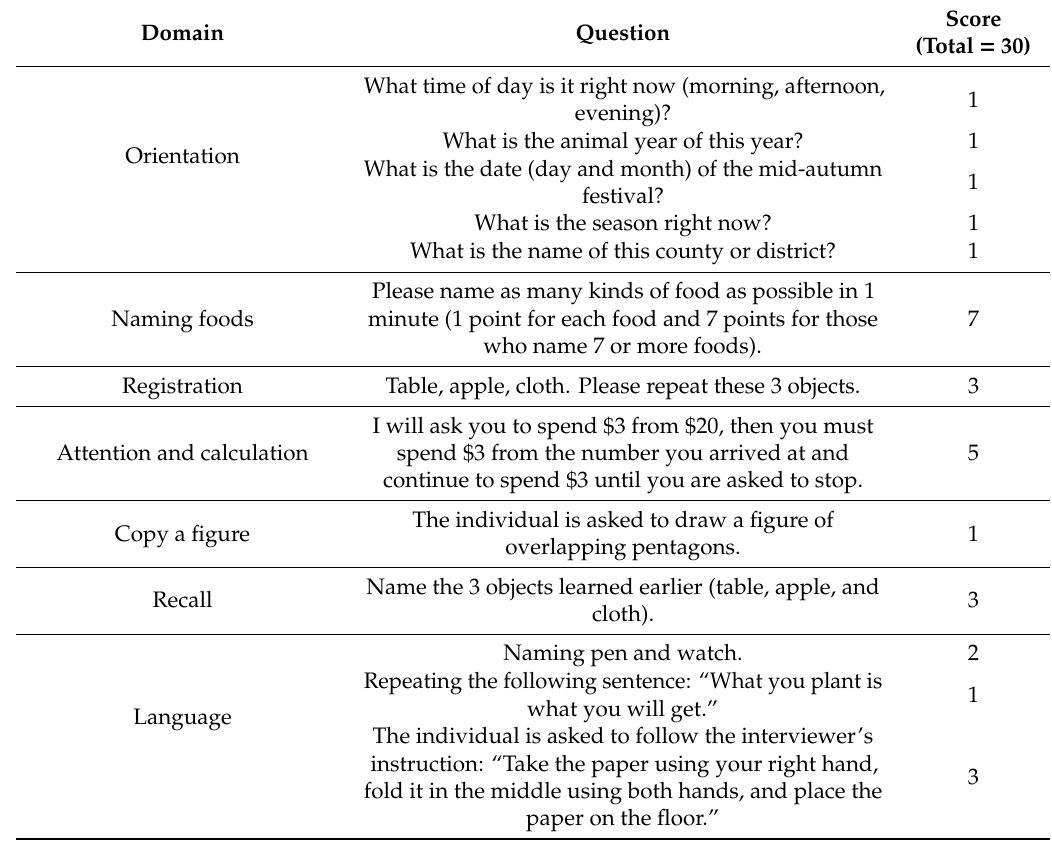
Table 1. The Chinese version of the mini-mental state examination adopted in the